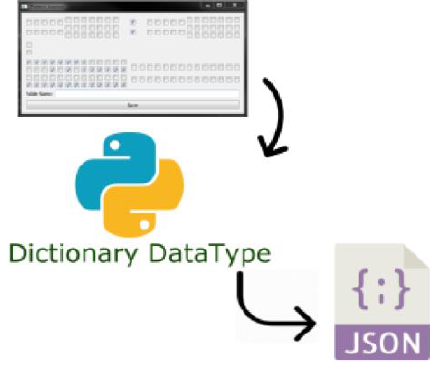
Figure 14. Data saving model.